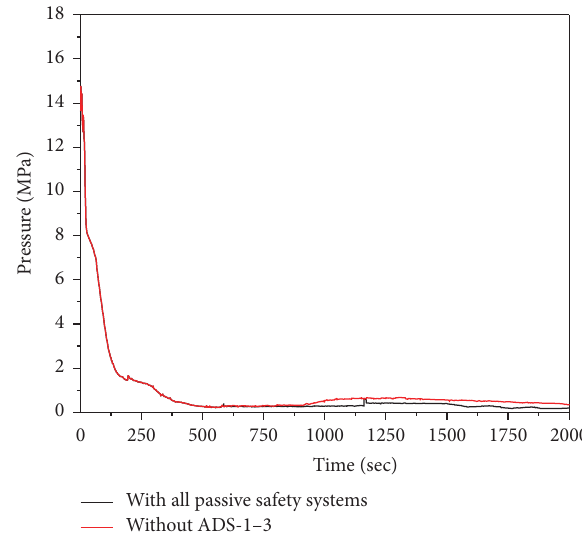
Figure 12: Comparison of pressure drop in case-1 and case-3.